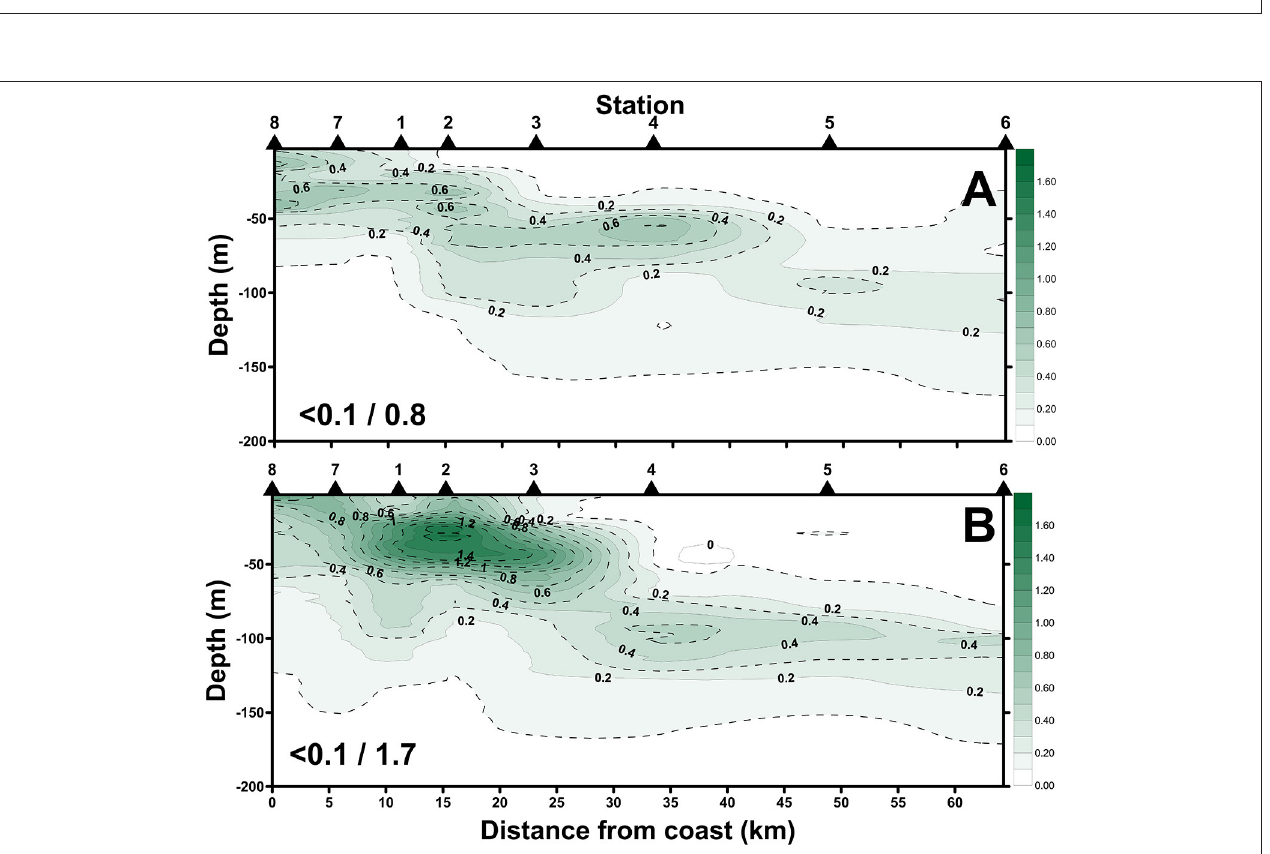
FIGURE 9 | Spatial changes of Chl- a concentrations along the sampling transect of the beginning-cast (A) and ending-cast (B) of the July cruise. Values in slash indicate the minimum and maximum in each panel.